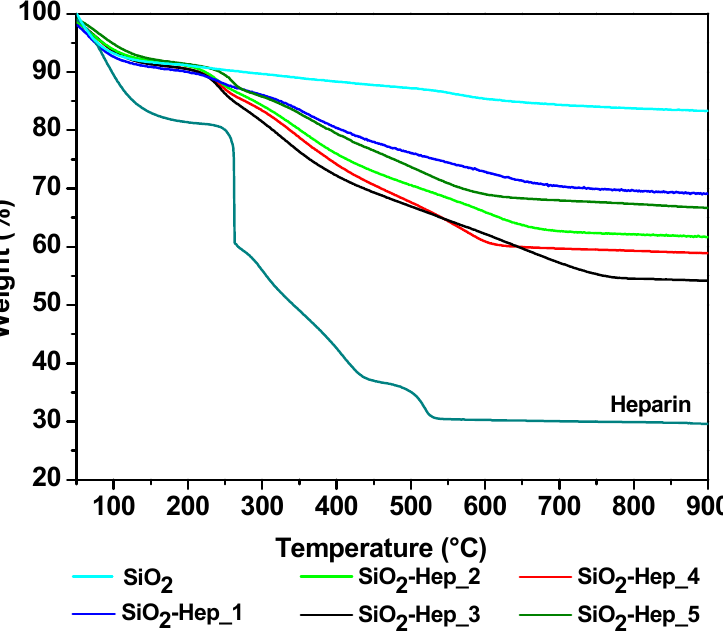
Figure 2. TGA thermograms of bare Heparin, SiO 2 , and SiO 2 -Hep hybrid nanoparticles. Table 2. Estimation of heparin weight percentage for all the hybrid samples. Sample Heparin (wt.